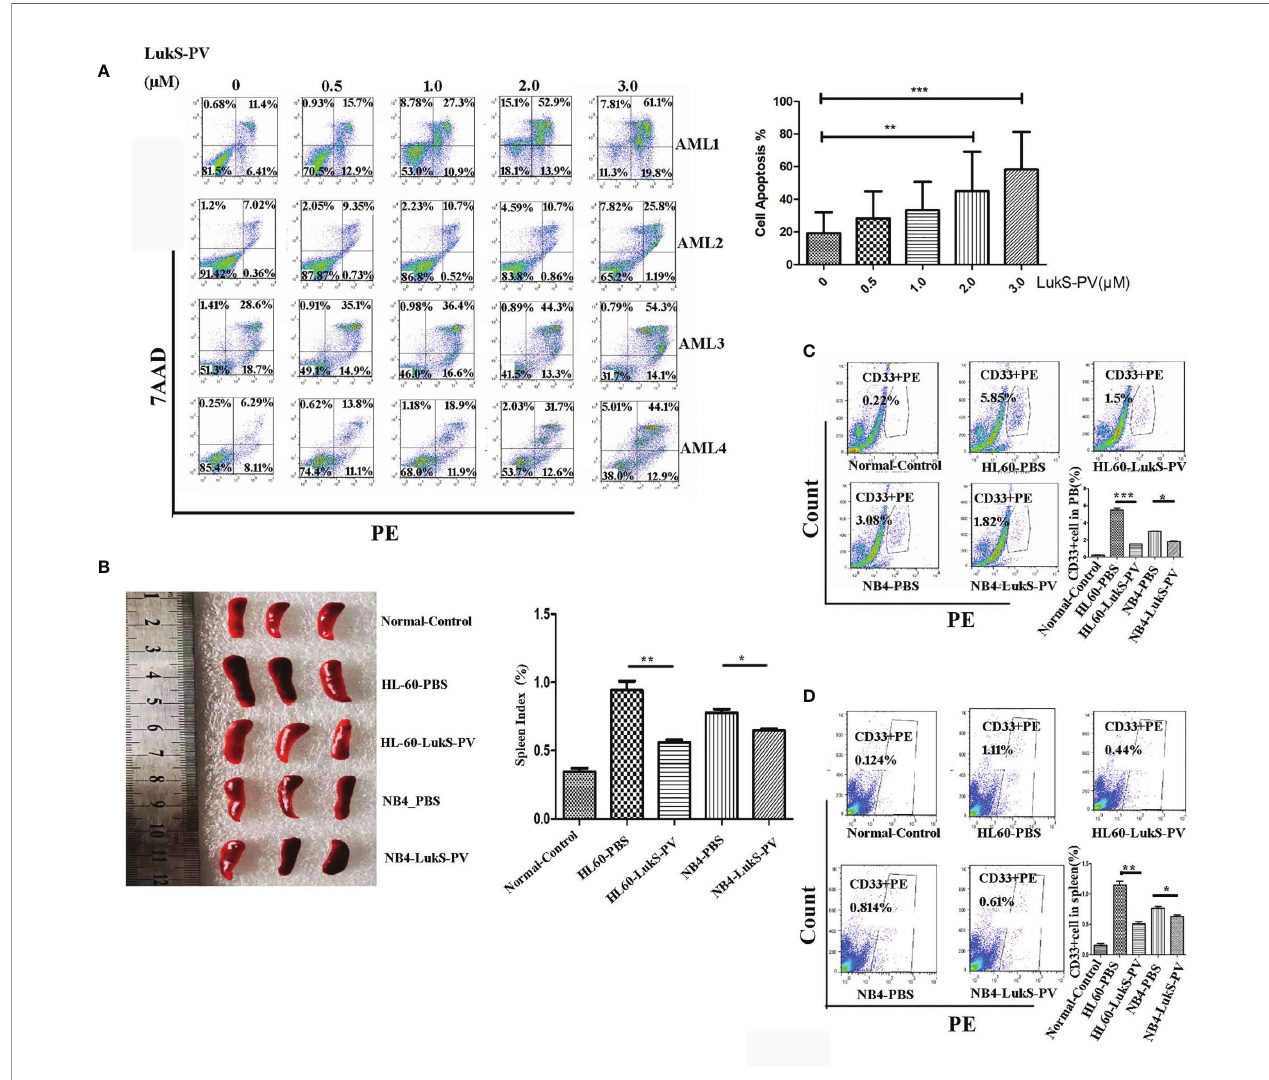
FIGURE 1 | LukS-PV induces apoptosis in vitro and inhibits cell invasion in vivo . (A) Flow cytometric analysis shows that treatment of primary acute myeloid leukemia (AML) blasts with LukS-PV induces apoptosis in a dose-dependent manner. (B) The spleen volume (left) and spleen index [(spleen weight/body weight) × 100, right] of mice. (C) The percentage of CD33+ cells in PB (peripheral blood). (D) The percentage of CD33+ cells in the spleen. Data are expressed as mean ± SD (n = 3). ns, not signi fi cant; *p < 0.05; **p < 0.01; ***p <